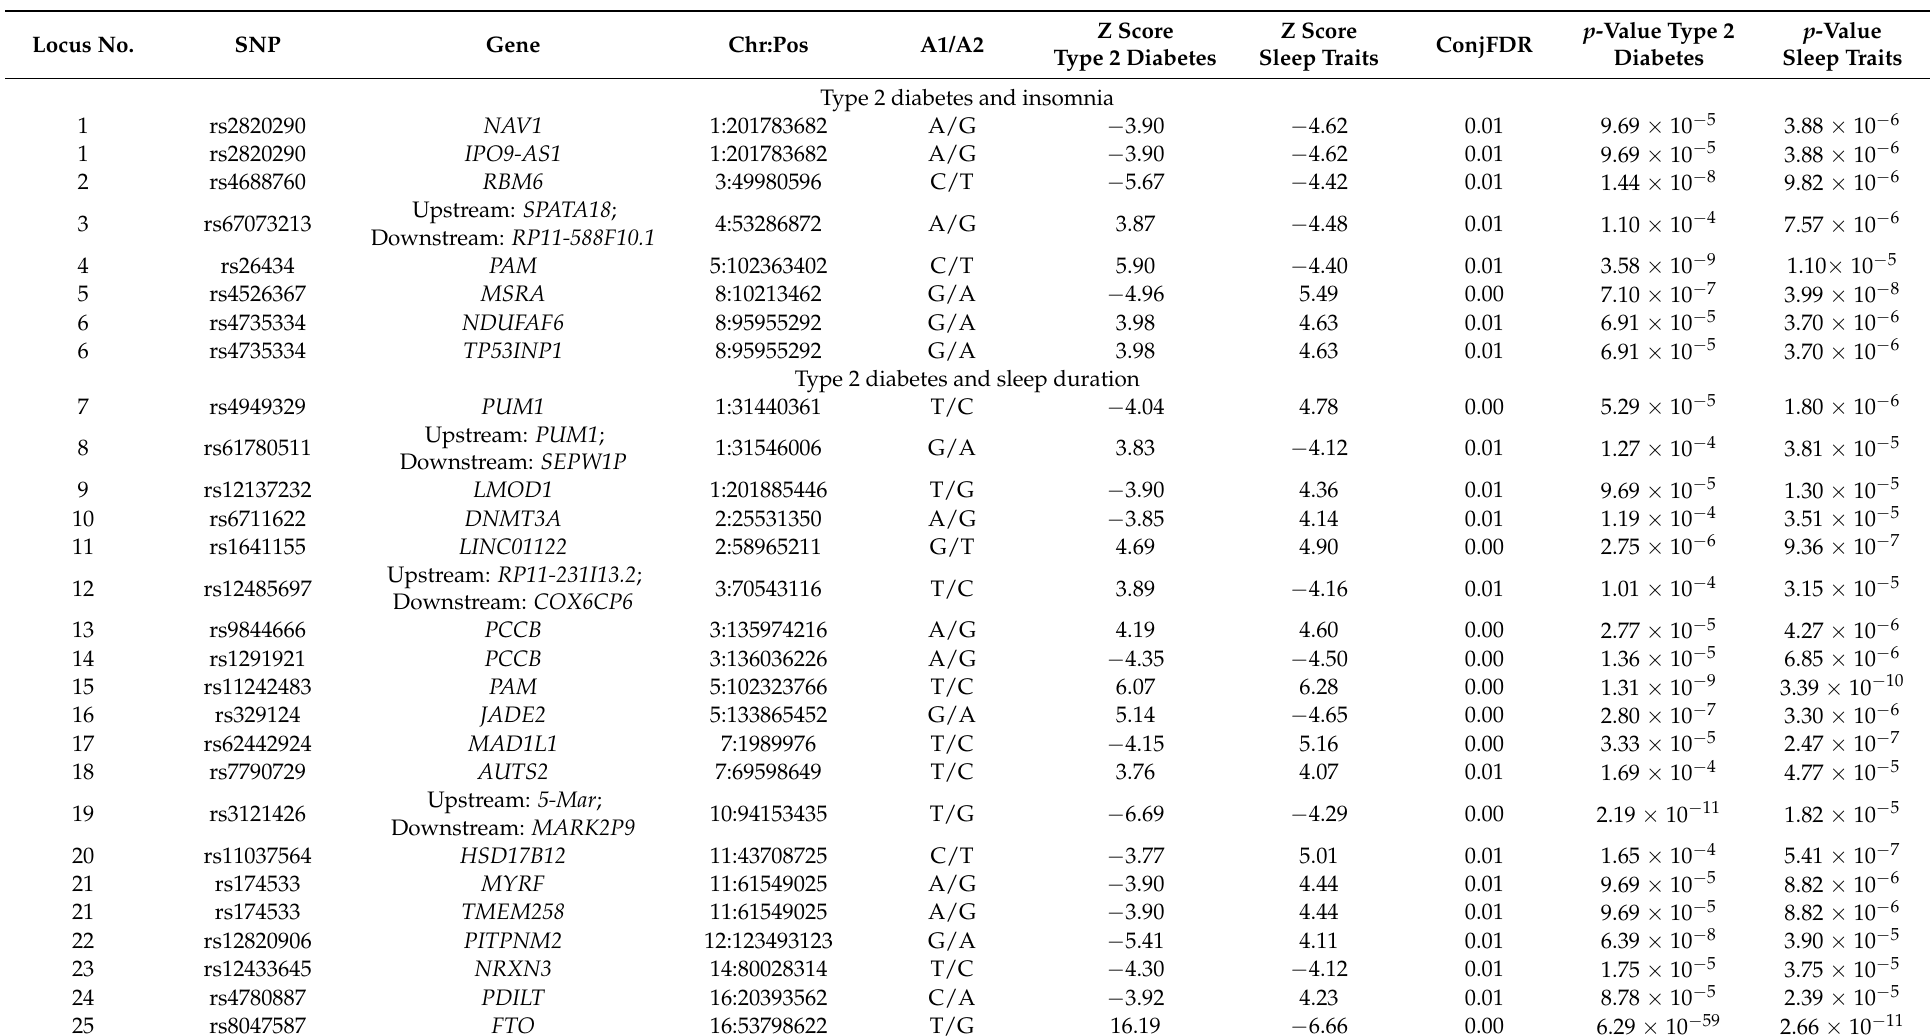
Table 1. Genetic loci with conjunction FDR < 0.01 shared between type 2 diabetes and sleep traits. Locus